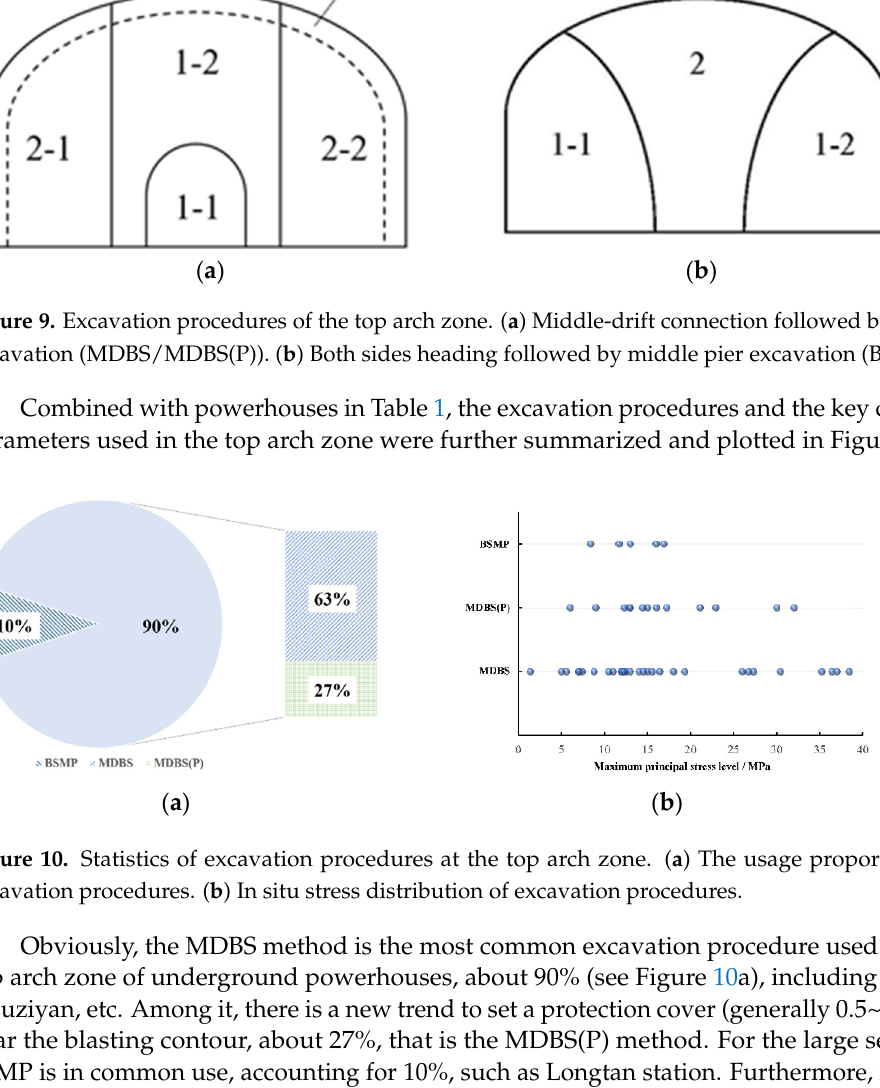
Figure 10. Statistics of excavation procedures at the top arch zone. ( a ) The usage proportion of excavation procedures. ( b ) In situ stress distribution of excavation procedures.